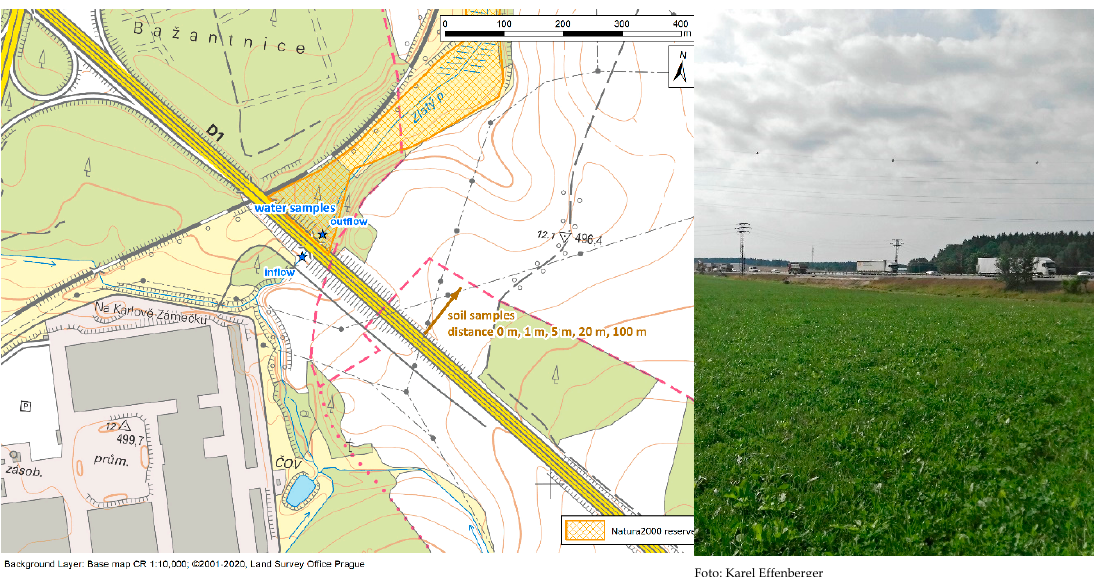
Figure 2. Situation map and photos of Site A.